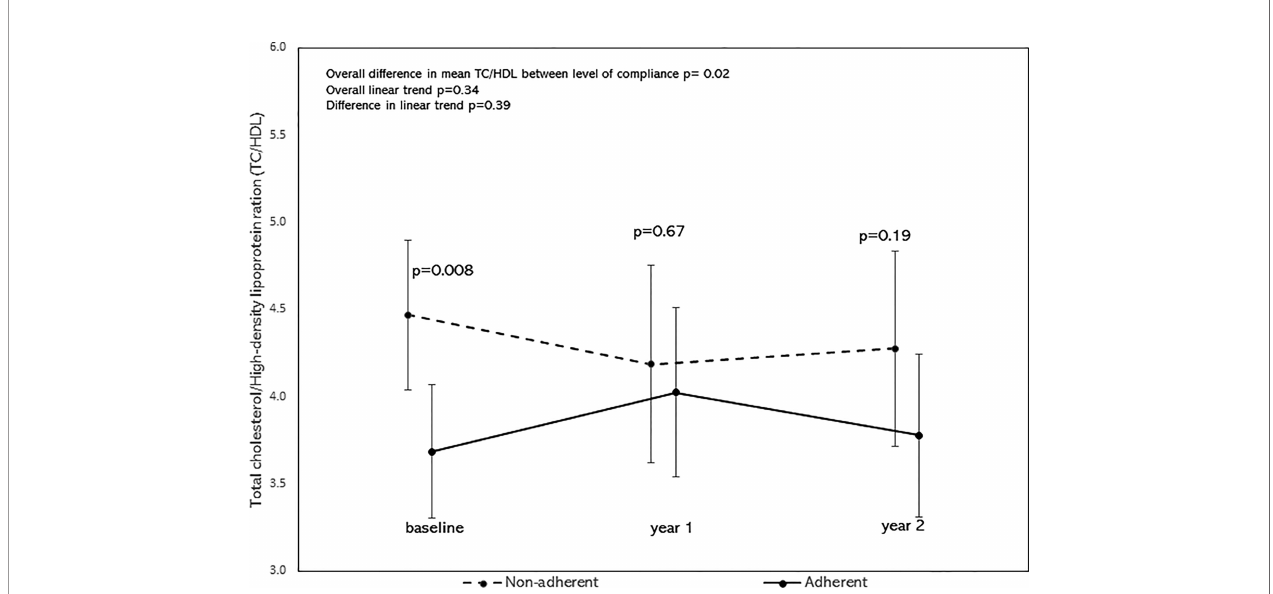
FIGURE 4 | Least square means of TC/HDL strati fi ed by adherence to nutrition visits with 95% con fi dence limits and trend analysis, adjusted for age, sex, race/ ethnicity, and BMI-z score. The overall mean of TC/HDL was signi fi cantly lower in the adherent group (p=0.02).